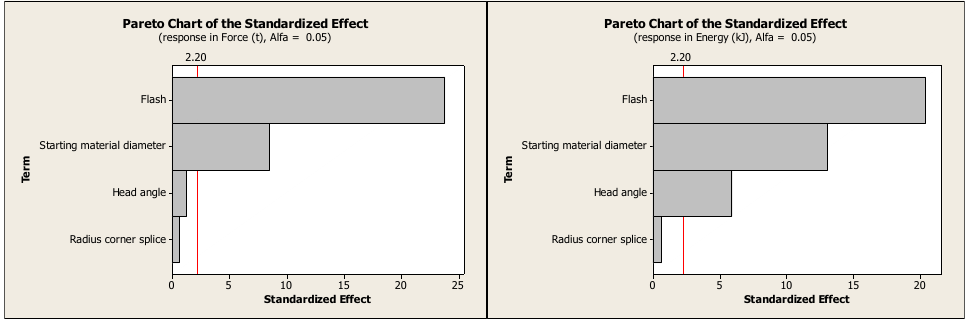
Figure 6. Influence order of the operating parameters on load and energy of the forming process.